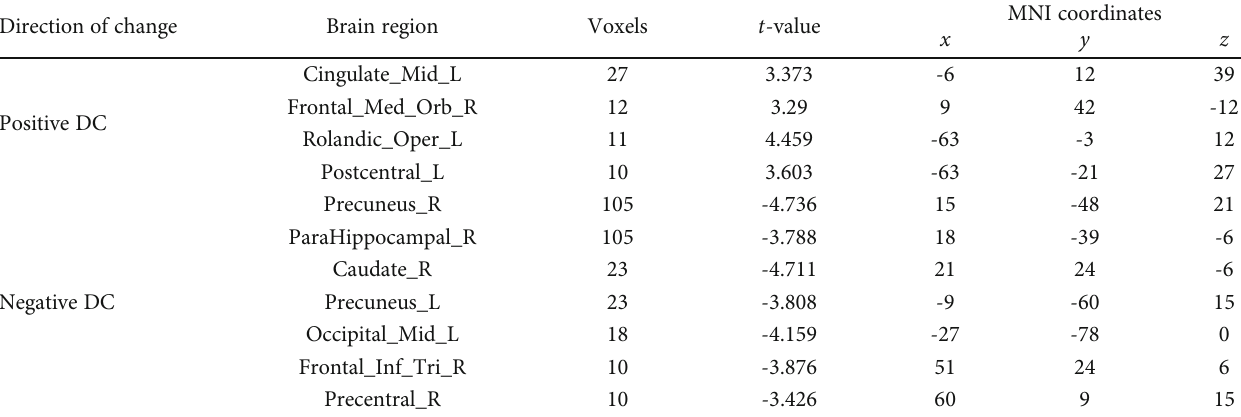
Figure 3: Changes in regional brain activity 12 months after traumatic amputation by using rs-fMRI. Di ff erences in the magnitude of ALFF between the same upper-limb amputee patients and control subjects. Same conventions as in Figure 1. Table 5: Relative regional changes in DC at 2